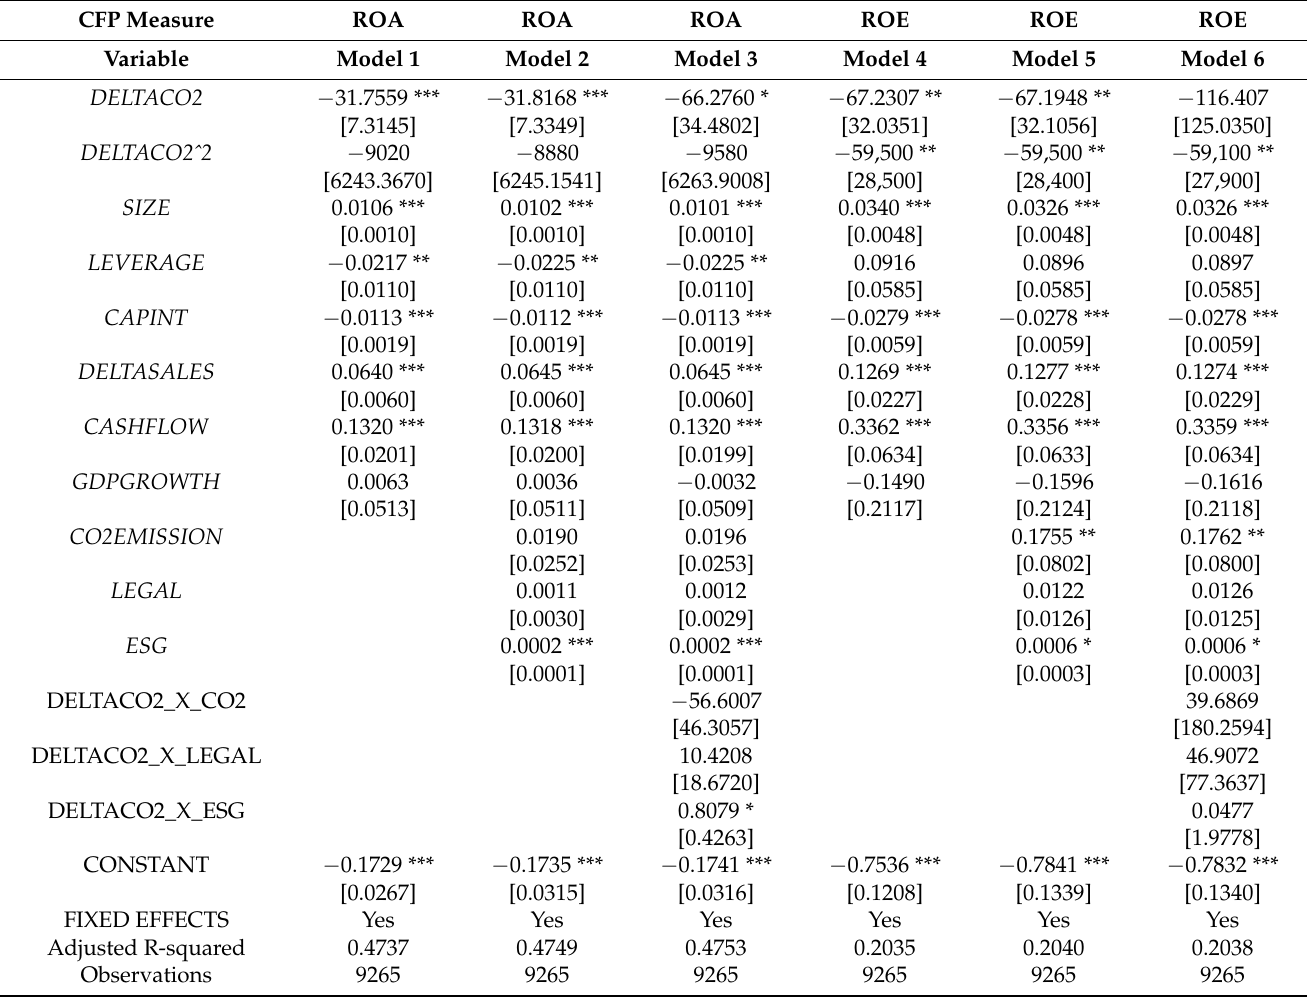
Table 3. Regression analysis on ROA and